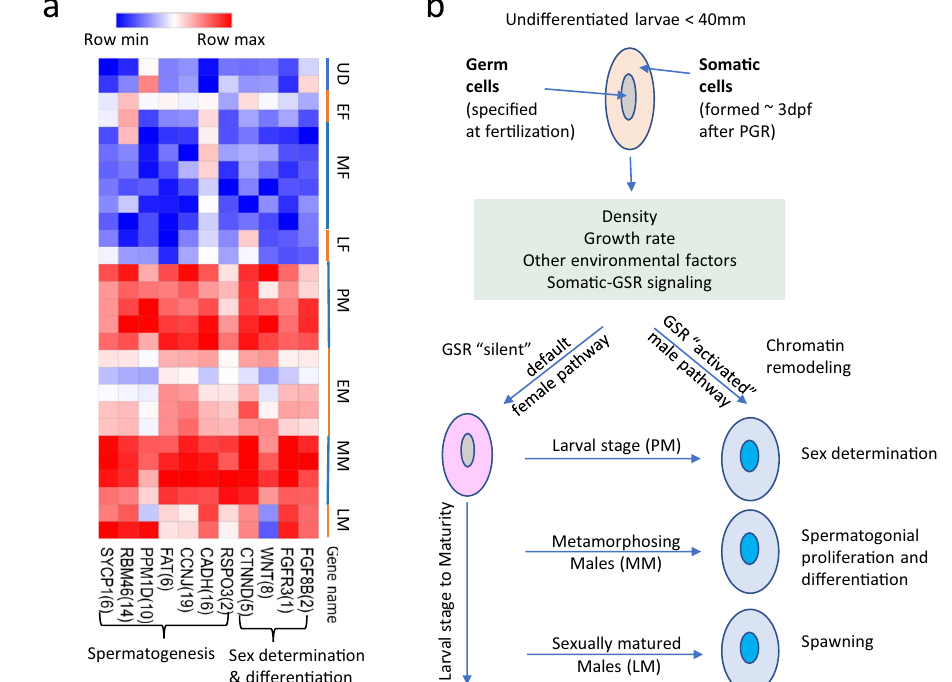
Fig. 4 Stage-speci fi c expression of key GSGs and a model for the role of the GSR in sea lamprey sex determination/differentiation. a Heatmap of the median expression of paralogs in gene families present in GSR that have known roles in sex determination or spermatogenesis in other vertebrates. The numbers in brackets are the number of paralogs of these genes present in GSR. UD represents undifferentiated larvae, EF, MF and LF represent early, mid and late females respectively and PM, EM, MM and LM represents prospective, early, mid and late males, respectively. b A hypothesized model for the potential role of GSR in sea lamprey sex determination/differentiation